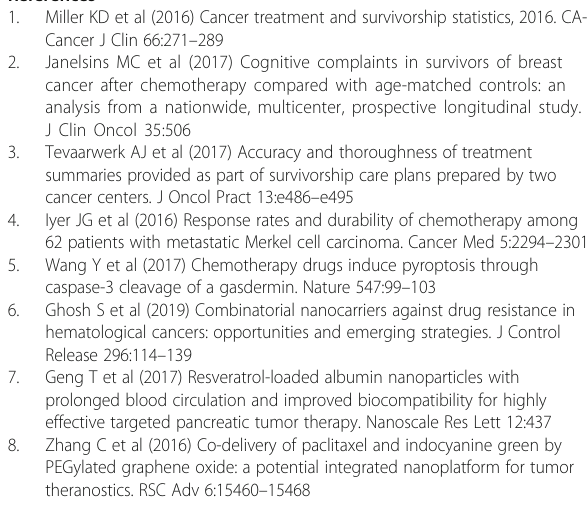
Additional file 1: Figure S1. The low resolution TEM image of TiS 2 nanosheets. Figure S2. XRD pattern of TiS 2 nanosheets. Figure S3. The FTIR spectra of the TiS 2 nanosheets, IR780-TiS 2 , and IR780-TiS 2 /RV, respectively. Figure S4. Ti content in tumor and major organs,